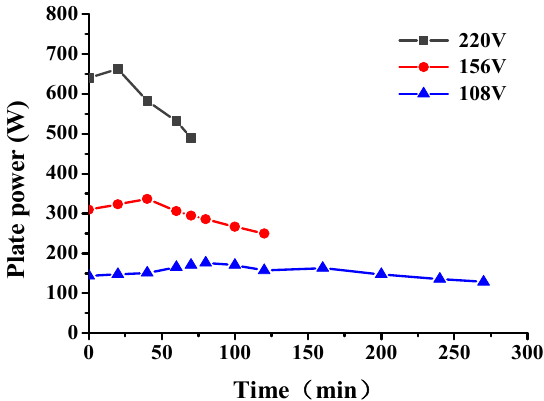
Figure 11. The input power of graphene composite conductive concrete slab changes with the on- voltage. Figure 12. Real-time snowmelt diagram: ( a ) 0 min, ( b ) 20 min, ( c ) 40 min, ( d ) 60 min, ( e ) 80 min, ( f ) 100 min, ( g ) 120 min.